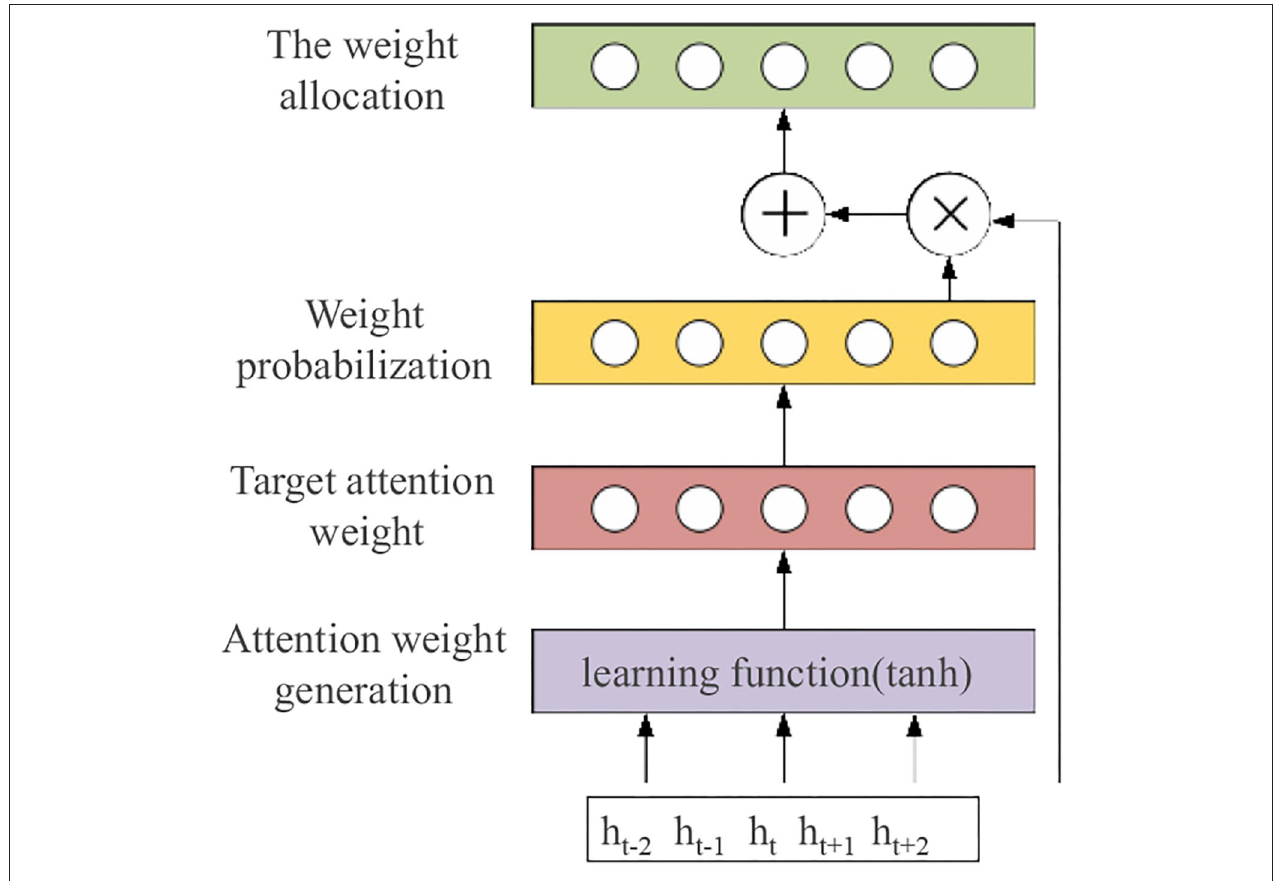
FIGURE 4 | The attention mechanism model structure.